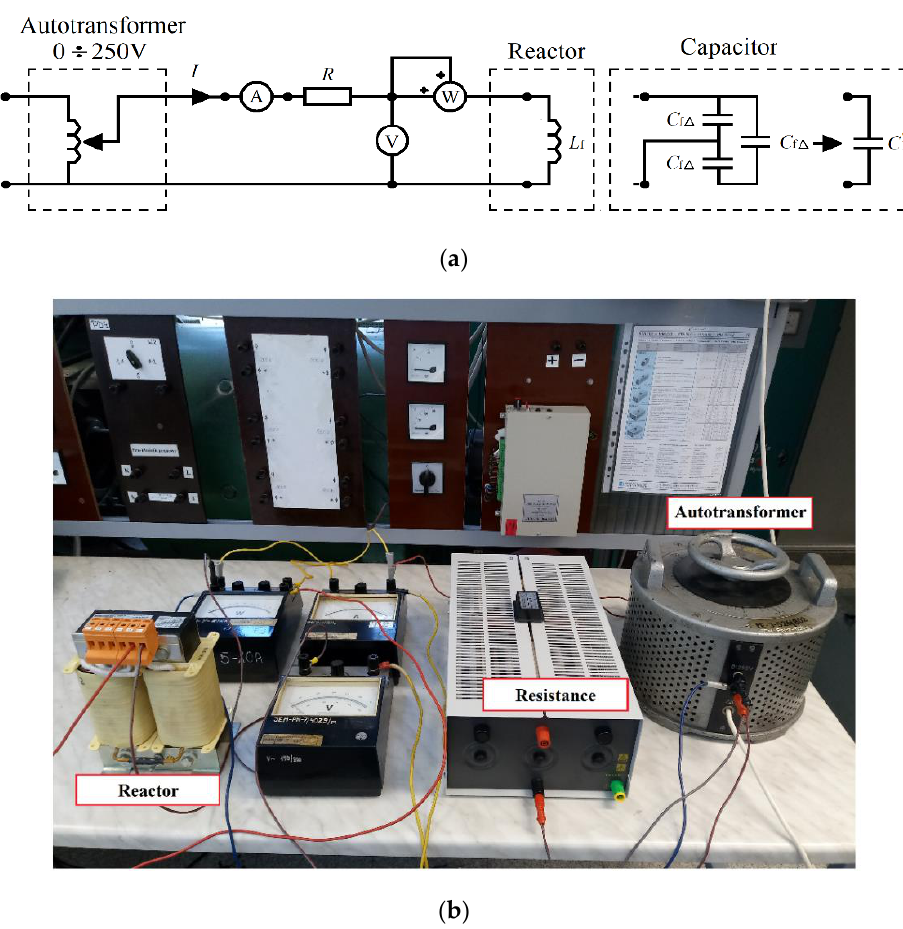
Figure A2. ( a ) Equivalent circuit in which the filter capacitors and reactors parameters were verified, ( b ) model in the laboratory.